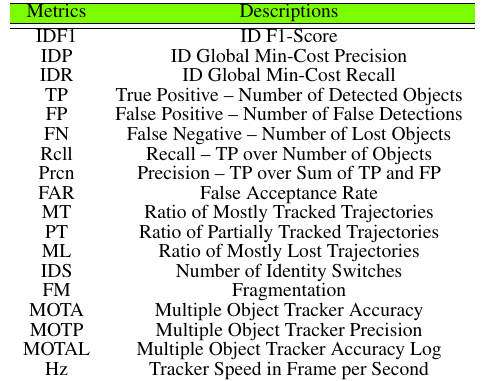
Figure 4. Network structures of GOTURN and our two modifications to it.